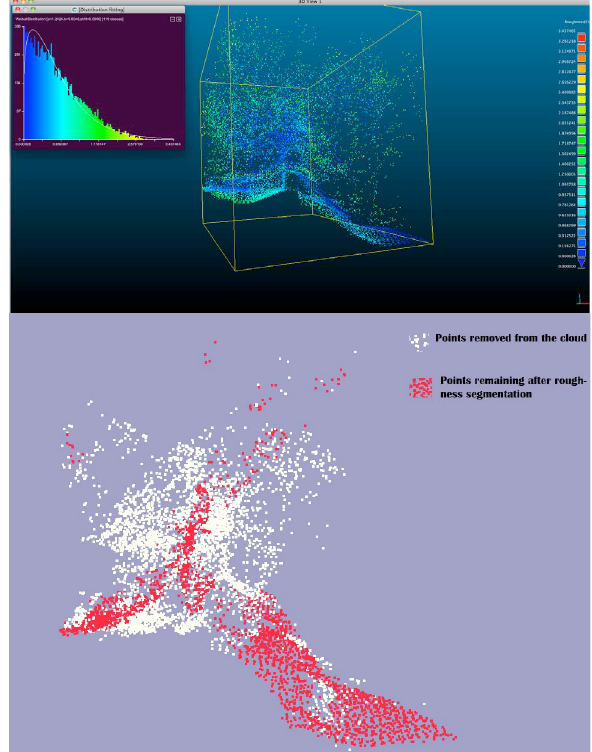
Figure 3(top) 5m roughness values in the Montfaucon scene, viewing the main wall end-on. (bottom) Points remaining after the roughness segmentation phase (red) seen within the point cloud